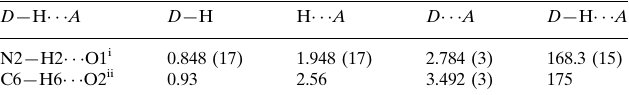
Hydrogen-bond geometry (A˚ , (cid:1)